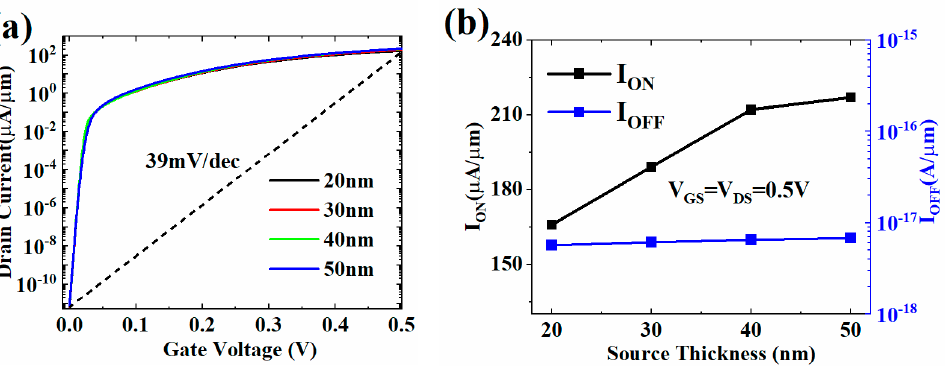
Figure 7. ( a ) Transfer characteristic and ( b ) I ON and I ON / I OFF with different T S values.